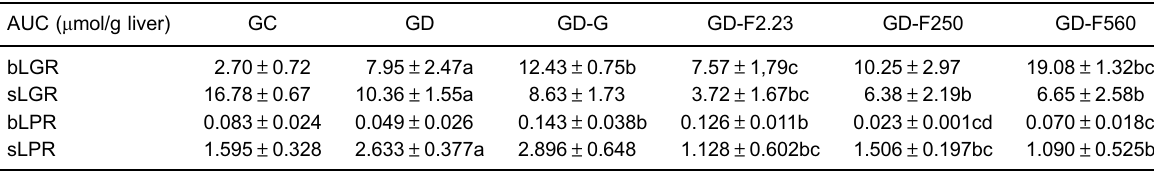
Table 1. Liver glucose and pyruvate release of mice from groups GC, GD, GD-G, GD-F2.23, GD-F250, and